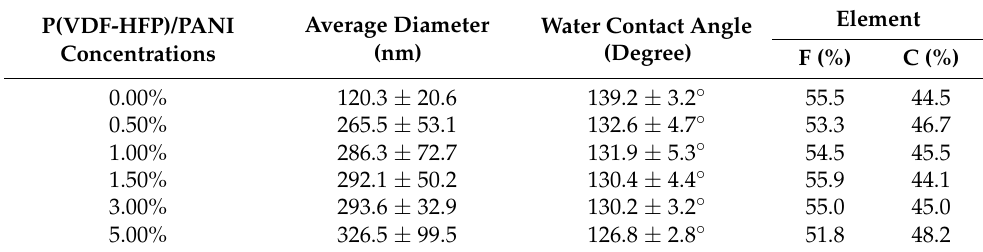
Table 1. Evaluated average diameter, water contact angle and elements of the samples.